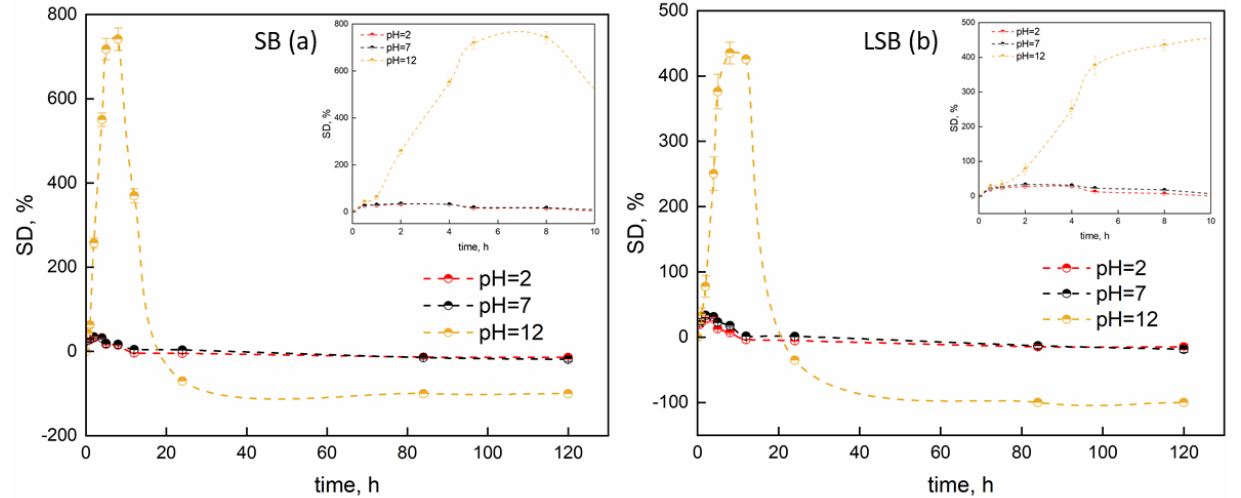
Figure 4. Swelling data for SBs ( a ) and LSBs ( b ) as function of pH